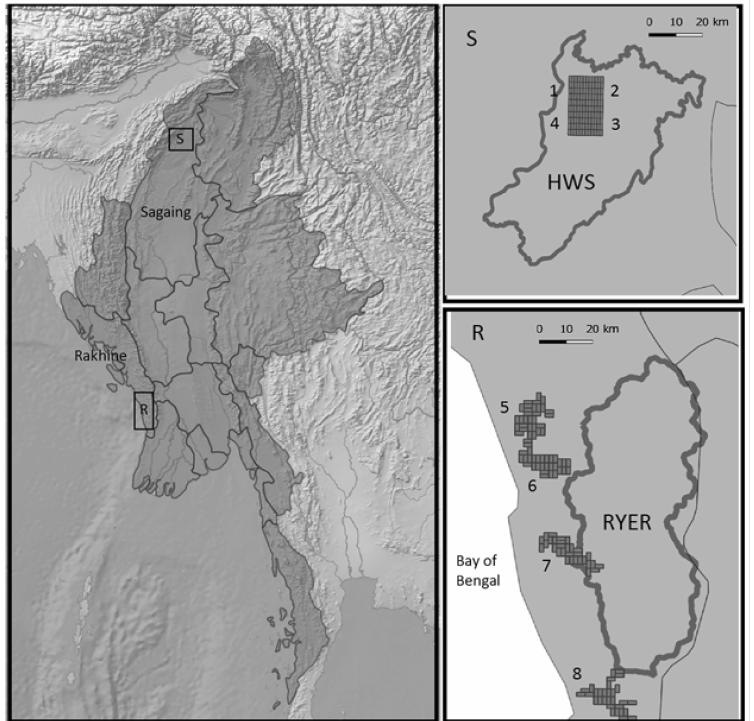
Figure 1. Study area locations in Myanmar (left): S. Detailed map of the sites in the Htamanthi Wildlife Sanctuary (HWS) (1, 2, 3, and 4), where dark grey represents the protected area borders and the grids represent the different allocations of the camera trap deployment. R. Detailed map of the sites in the Rakhine Yoma Elephant Range (RYER) (5, 6, 7, and 8), where dark grey represents the protected area borders, and the grids represent the different allocations of the camera trap deployments. Light grey represents states of Myanmar divided by continuous